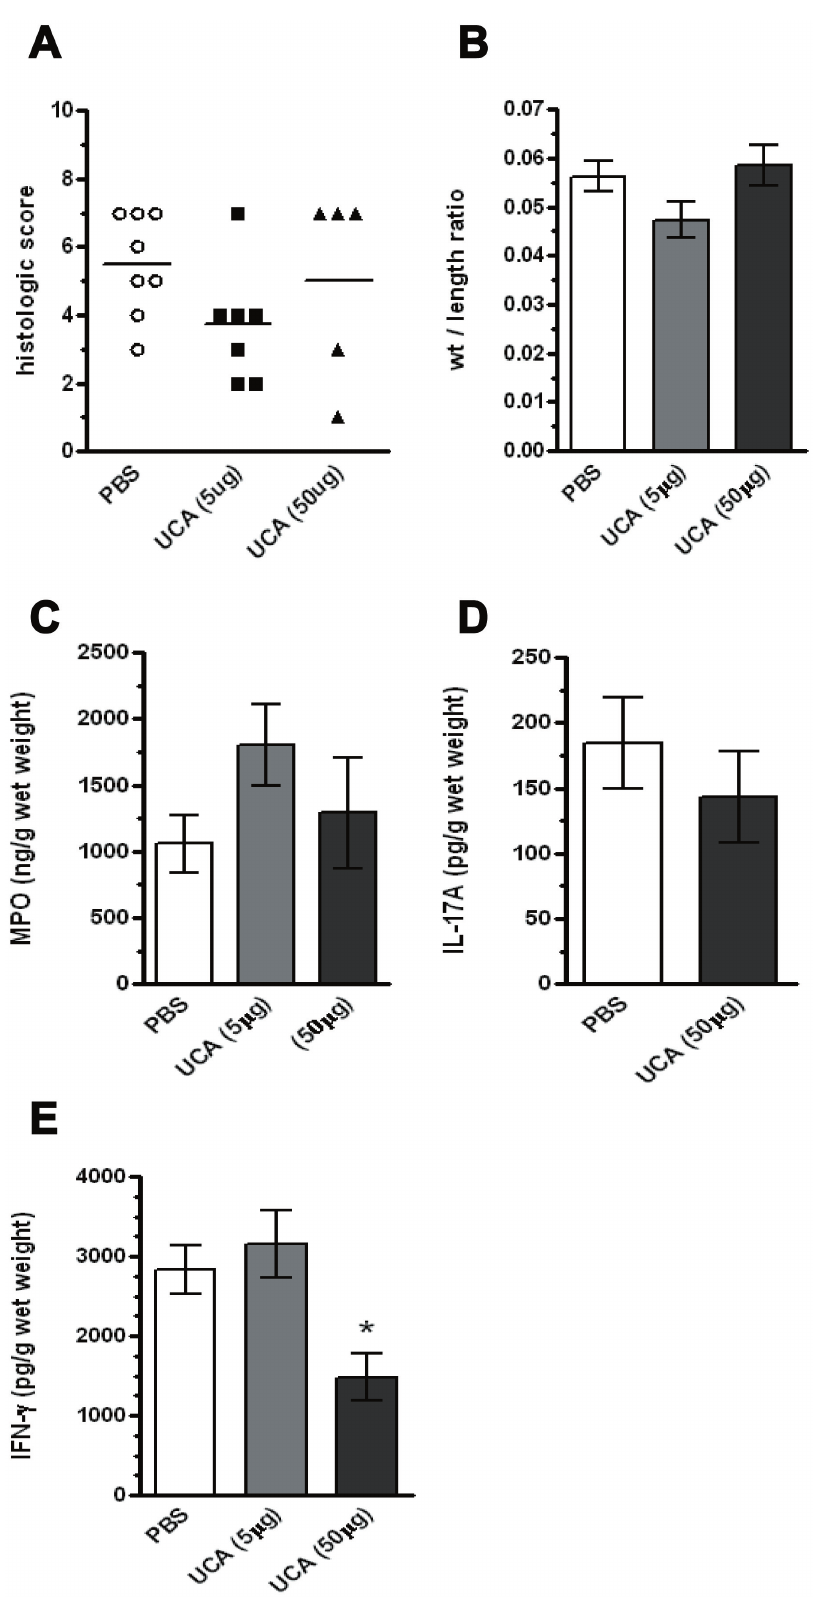
Figure 5. cis -UCA does not ameliorate colitis in IL-10 2 / 2 mice. 129Sv/EV IL-10 2 / 2 mice were injected subcutaneously along the dorsal axis every 2 days for 24 days with either 5 or 50 m g cis -UCA, or vehicle (PBS) (n=5–8). Mice were weighed every second day. cis -UCA had no effect on colonic histological score (A), weight/length ratio (B), MPO levels (C), or IL-17A levels (D). cis -UCA (50 m g) did reduce levels of colonic IFN c in IL-10 2 / 2 mice as compared with PBS or cis -UCA (5 m g) treated (E). *: p , 0.05 UCA (50 m g) compared with PBS or UCA (5 m g).